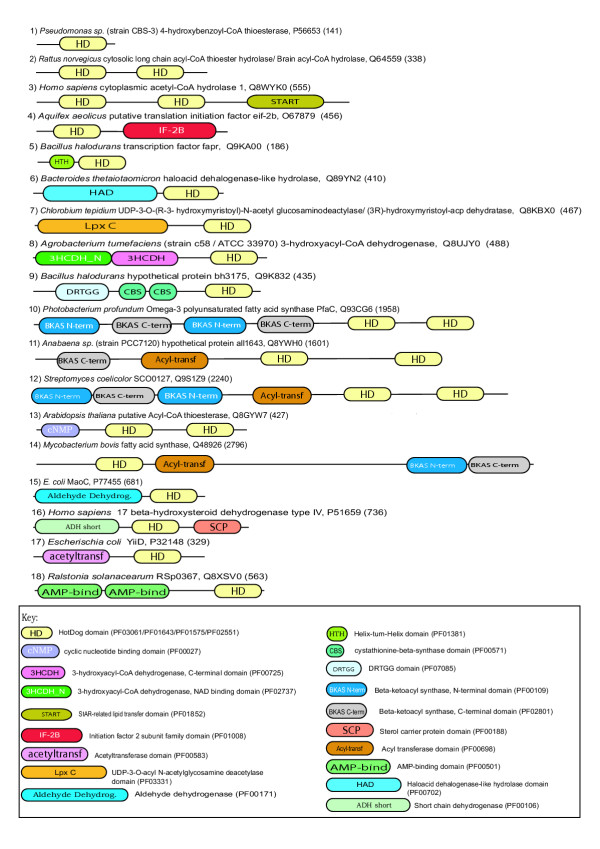
A schematic Figure showing the various domain organizations of proteins with a HotDog domain. For each distinct architecture we show an example protein, the species it has come from and its length is shown in parentheses. The key identifies all the domains in the Figure and also includes the Pfam accession number or numbers describing each domain.